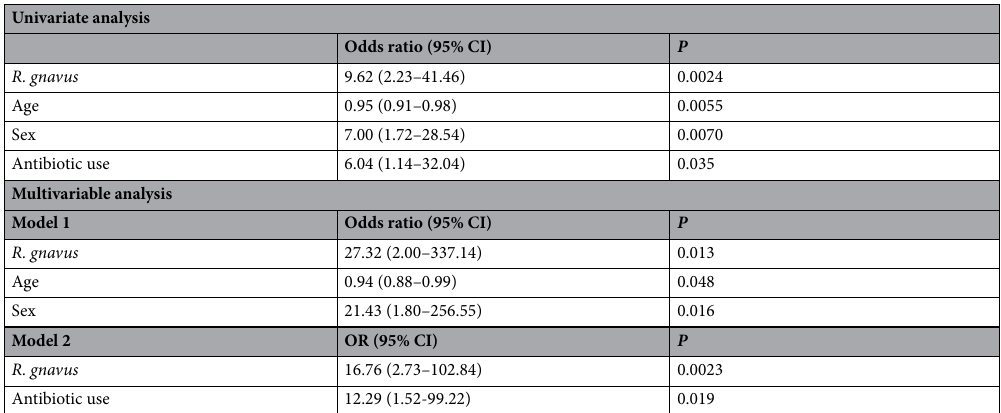
Table 3. Univariate and multivariable analysis to test the association of the high relative abundance of R. gnavus > 0.003 with MMD as compare to the control. In multivariable analysis, association of the relative abundance of Ruminococcus gnavus ( R. gnavus ) with moyamoya disease (MMD) was tested with adjustment for age and sex (model 1), with adjustment for history of antibiotics use (model 2). The p.R4810K mutation was not included because none of the controls have the mutation (odds ratio should be infinite).